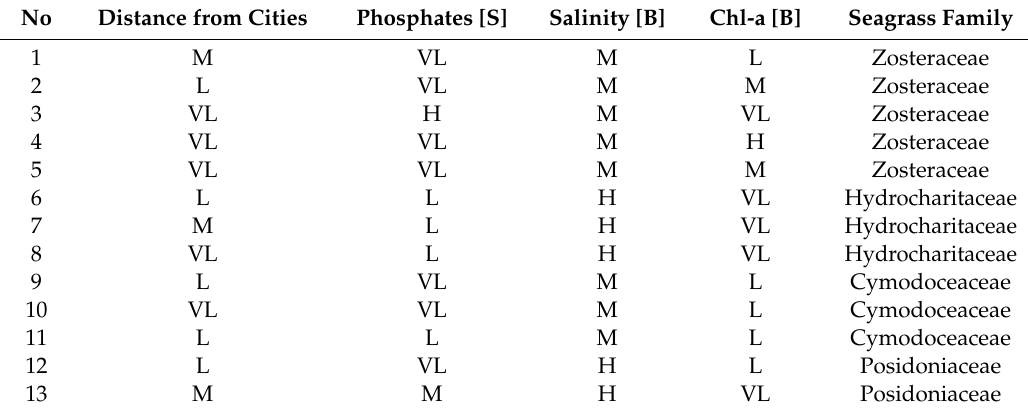
Table 4. Indicative fuzzy rules in initial FIS test, where VL represents locations with values belonging to the Very Low fuzzy set, L in the Low, M in the Medium, and H in the High fuzzy set. No